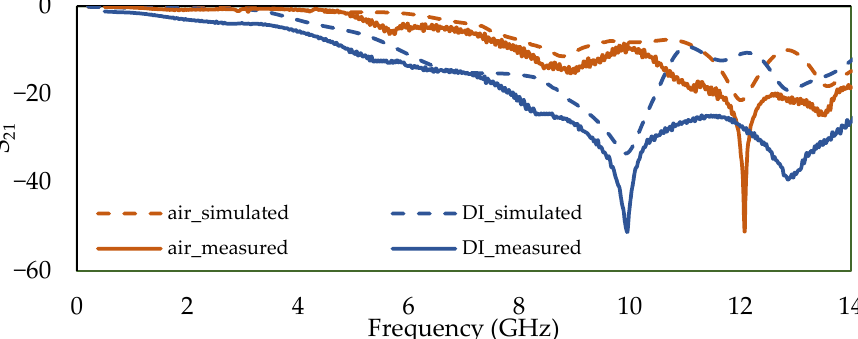
Figure 7. HFSS model of our proposed microwave-based microfluidic sensing device. Figure 8. Simulated vs. measured frequency response of the insertion loss (S 21 ) for empty microchannel and filled with DI water.